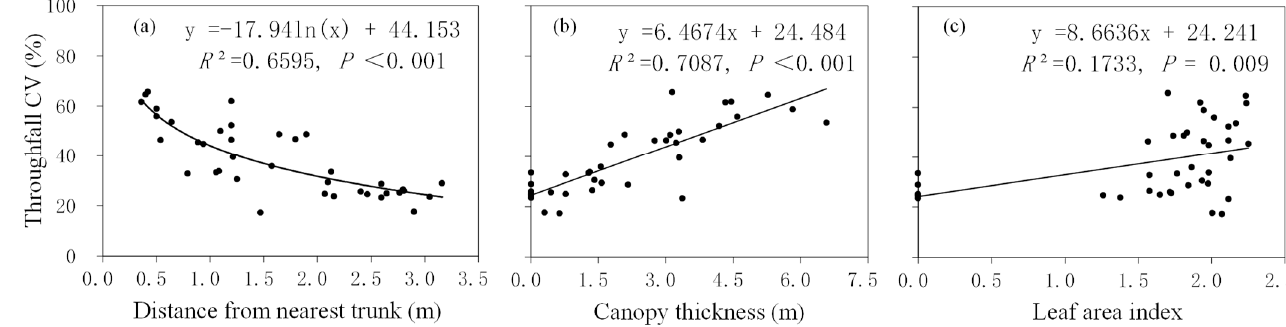
Figure 6. Coefficient of variation of throughfall (throughfall CV CS ) as a function of distance from nearest trunk ( a ), canopy thickness ( b ), and leaf area index ( c ).